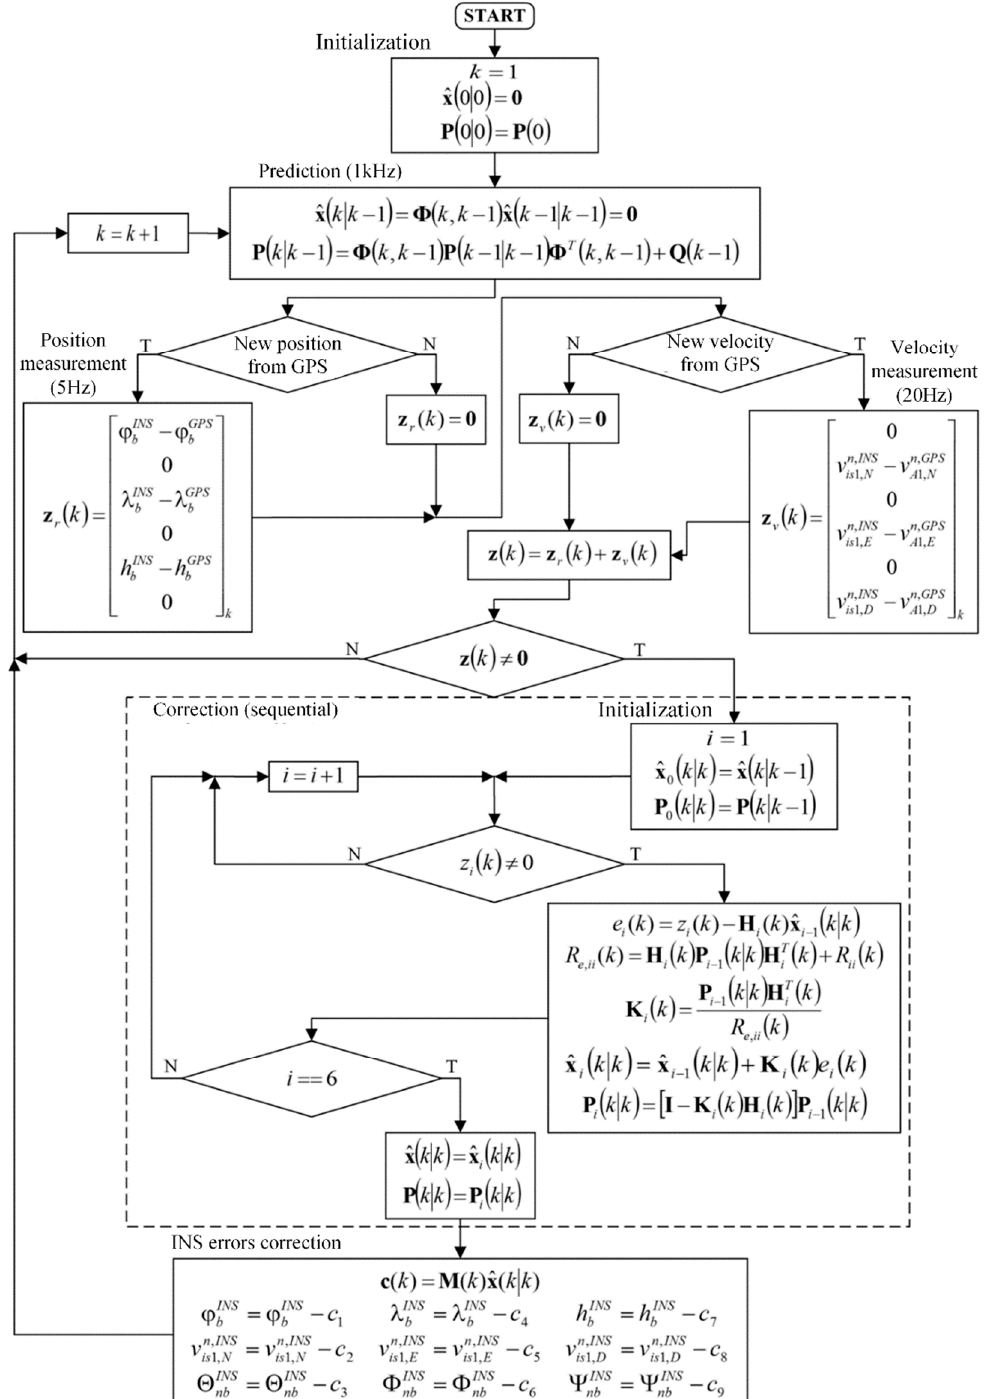
Figure 2. Sequential Kalman filter for INS/Global Positioning System (GPS) system with feed-backward correction.